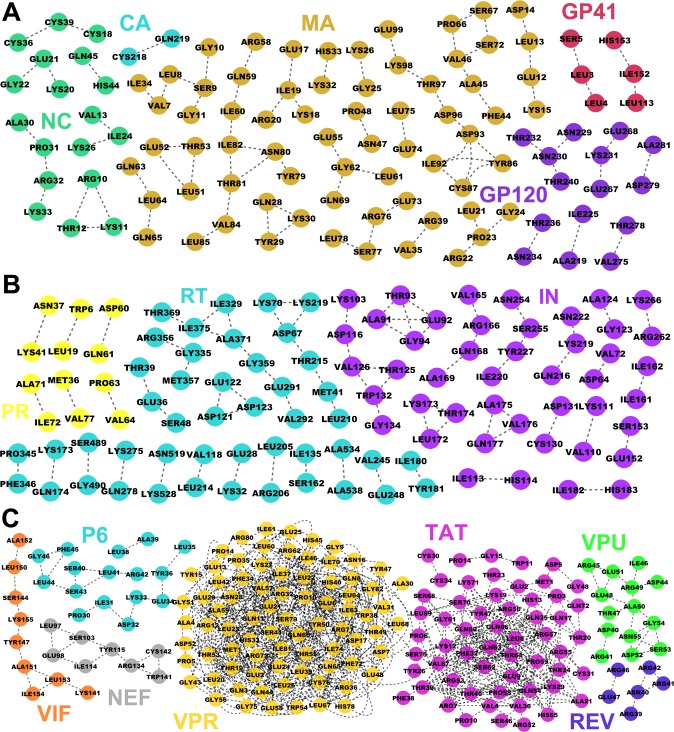
Coevolution networks of HIV-1 proteins.The nodes represent the amino acid residues in HIV-1 proteins while the edges are the coevolving relationships among the residues. The amino acid labels come from the protein tertiary structures (Table 2). The proteins are classified into three categories, including structural proteins (A), viral enzymes (B), and accessory proteins (C).